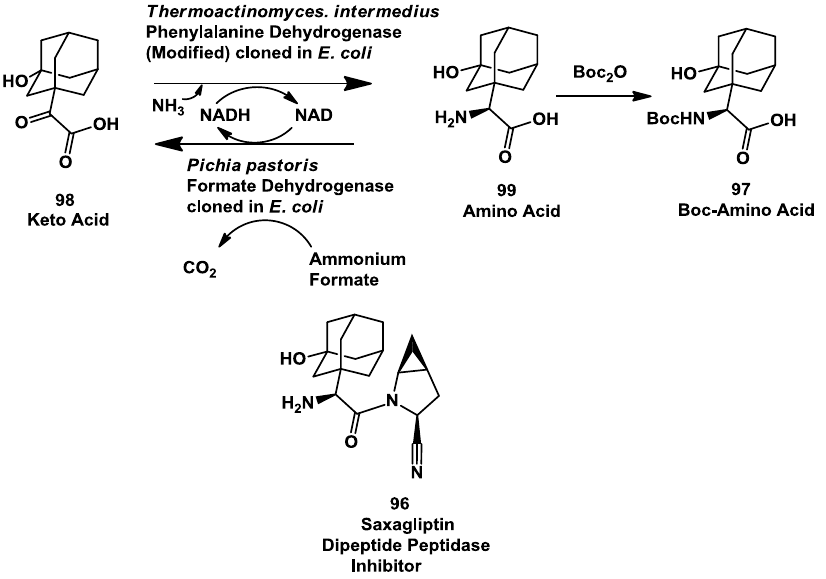
Figure 26. Saxagliptin: Enzymatic reductive amination of 2-(3-hydroxy-1-adamantyl)-2-oxoethanoic acid.